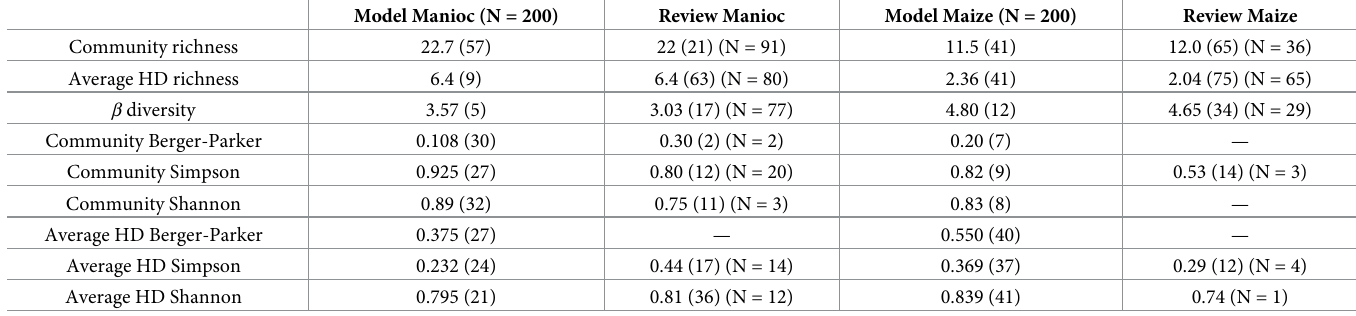
Table 2. Comparison of diversity indexes between model values and literature review values for manioc and maize. The number in parenthesis is the standard devia- tion; N is the sample